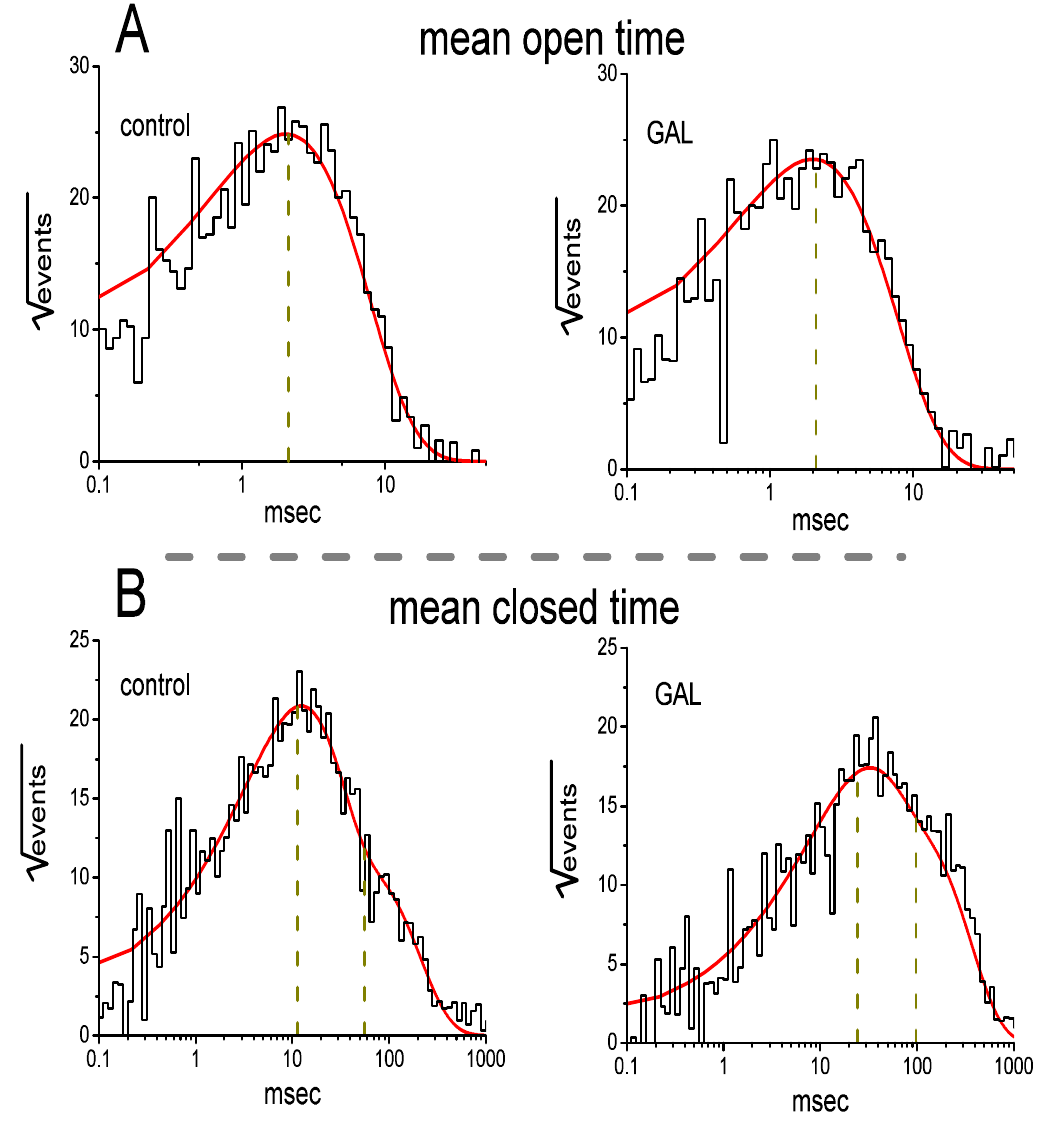
Figure 4. Effect of GAL-021 on mean open (A) and closed (B) times of BK Ca channels in GH 3 cells. Inside-out current recordings were made in these experiments and the potential was maintained at +60 mV. Cells were immersed in high-K + solution which contained 0.l μ M Ca 2+ . The open- and closed-time histograms under control conditions (i.e., GAL-021 is not present) are illustrated in the left side of each panel, while those acquired during the exposure to 3 μ M GAL-021 are in the right side. Of note, the abscissa and ordinate in each panel show the scale of apparent open- or closed-time histograms (msec, in a logarithmic scale) and the square root of the event numbers ( √n ), respectively. Control data were acquired from measurements of 361 channel openings with a total record time of 1 min, whereas those taken in the presence of GAL-021 were taken from 333 channel openings with a total recording time of 2 min. Nonlinear continuous line in each histogram was least-squares fitted by single- or two-exponential function, while the broken line(s) in each lifetime distribution are pointed at the values of the time constants in open or closed state(s). Of note, the fast and slow components in mean closed time of the channel became prolonged in the presence of 3 μ M GAL-021, despite its inability to modify mean open time.